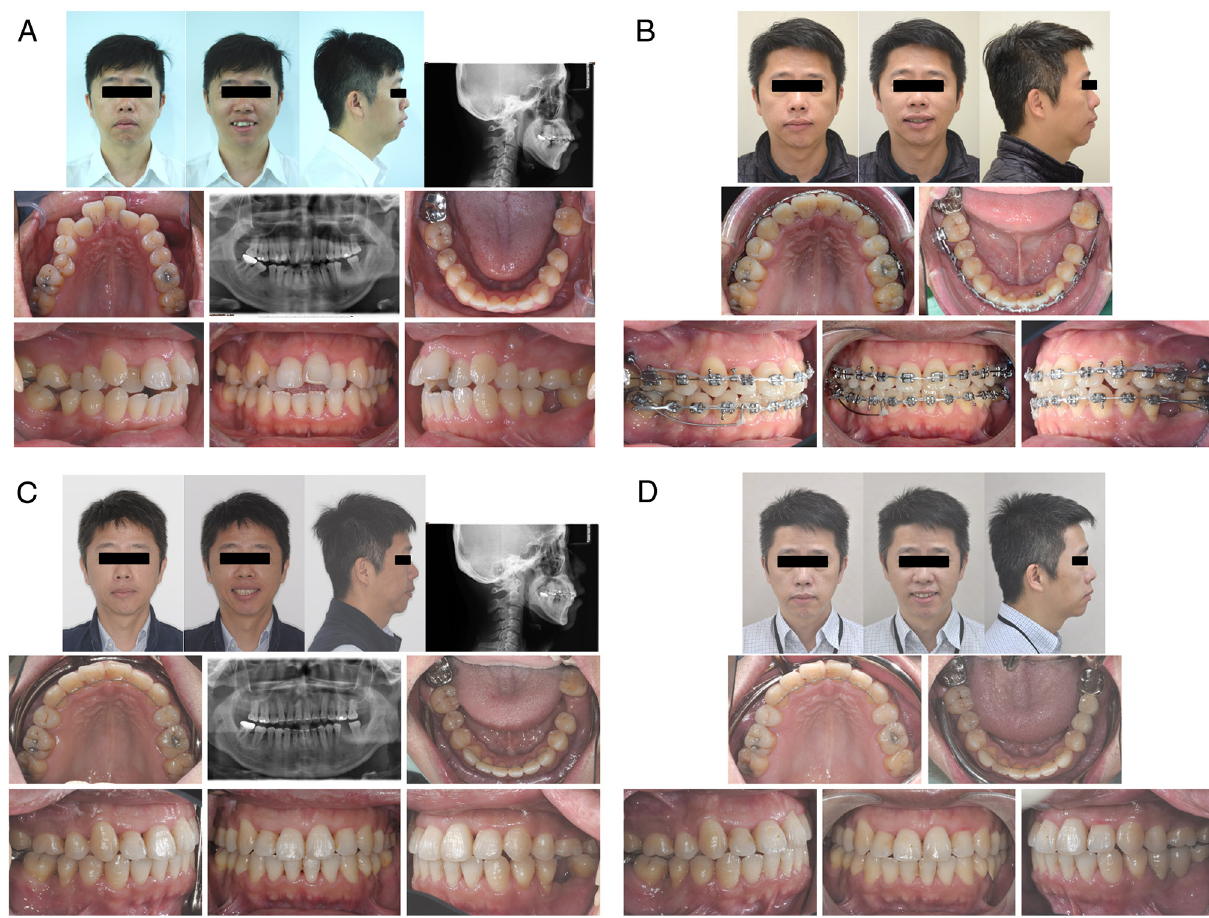
Figure 1. Case 1: (A) A 43-year-old male patient with skeletal Class II relationship, hyperdivergent long-face pattern, retrognathic chin, and lip protrusion. Missing right and left mandibular first molars with an atrophic ridge. (B) Bilateral zygomatic mini-screws were inserted for anterior retraction and posterior intrusion. Space closure of the right mandibular first molar area, and uprighting of the right mandibular second and third molars after PAOO. (C) Patient after 3 years of treatment. (D) Patient 1 year 11 months after